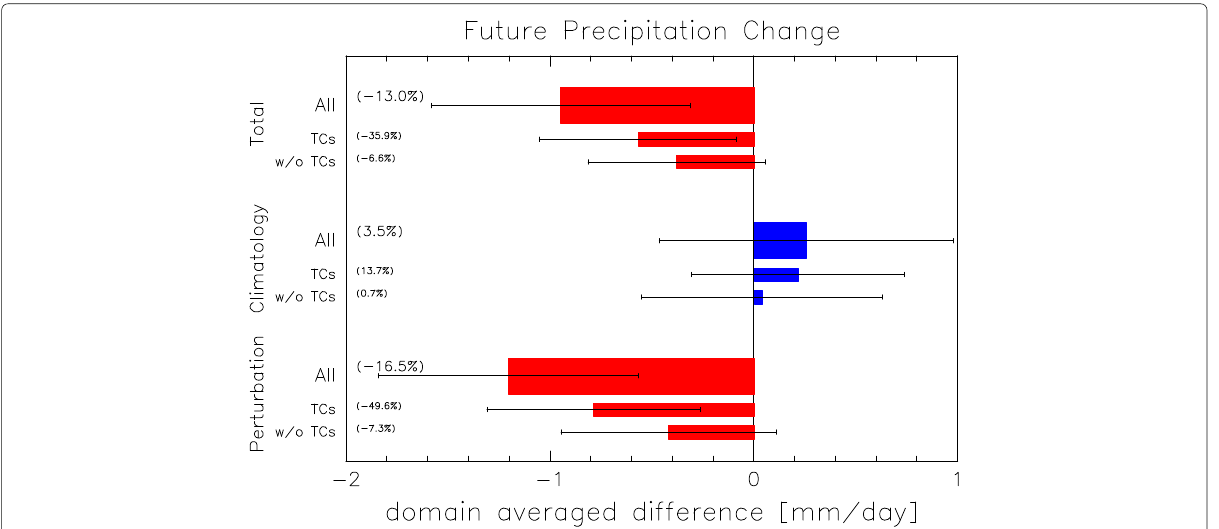
Fig. 4 Contribution of each component to domain-averaged 25-year JJAS mean daily precipitation difference. The total difference, the difference due to climate difference, and that due to perturbation are shown at the top, middle, and bottom, respectively, on the vertical axis. These differences are further divided into ones associated with tropical cyclones and other factors. The error bars represent the 95% confidence interval of Welch’s statistics. The percentages represent the ratios of the difference to the total precipitation in the Present-DDS